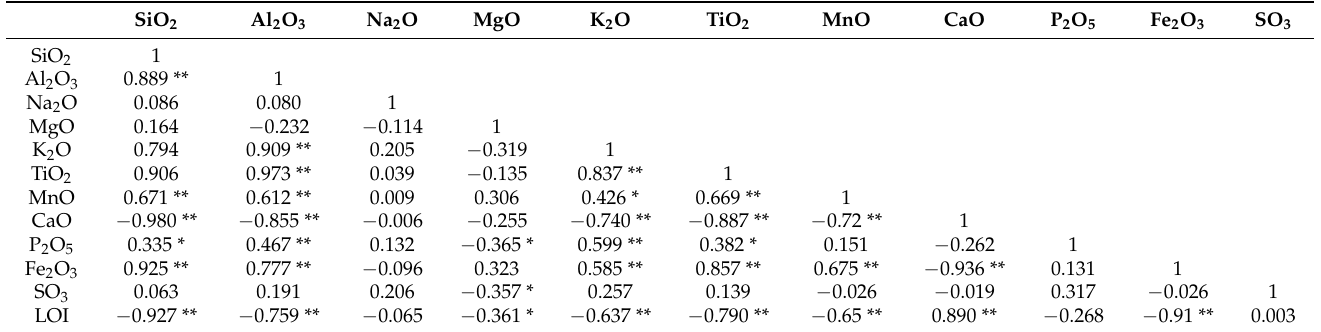
Table 8. Pearson’s correlation coefficients for major oxides in studied